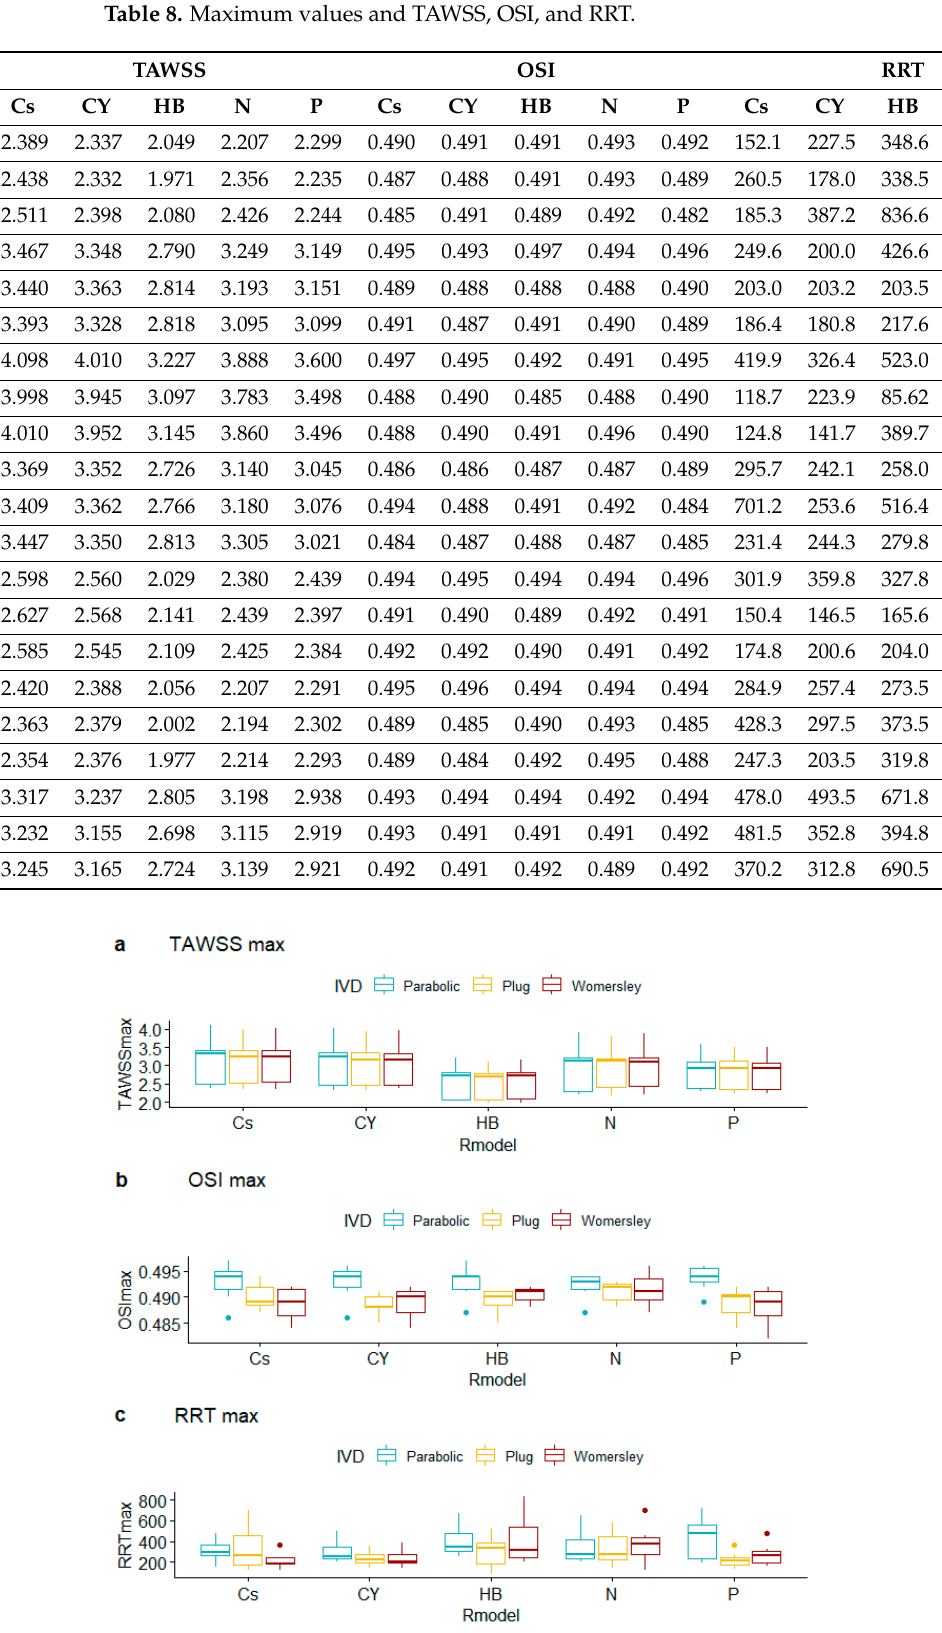
Table 8. Maximum values and TAWSS, OSI, and RRT.